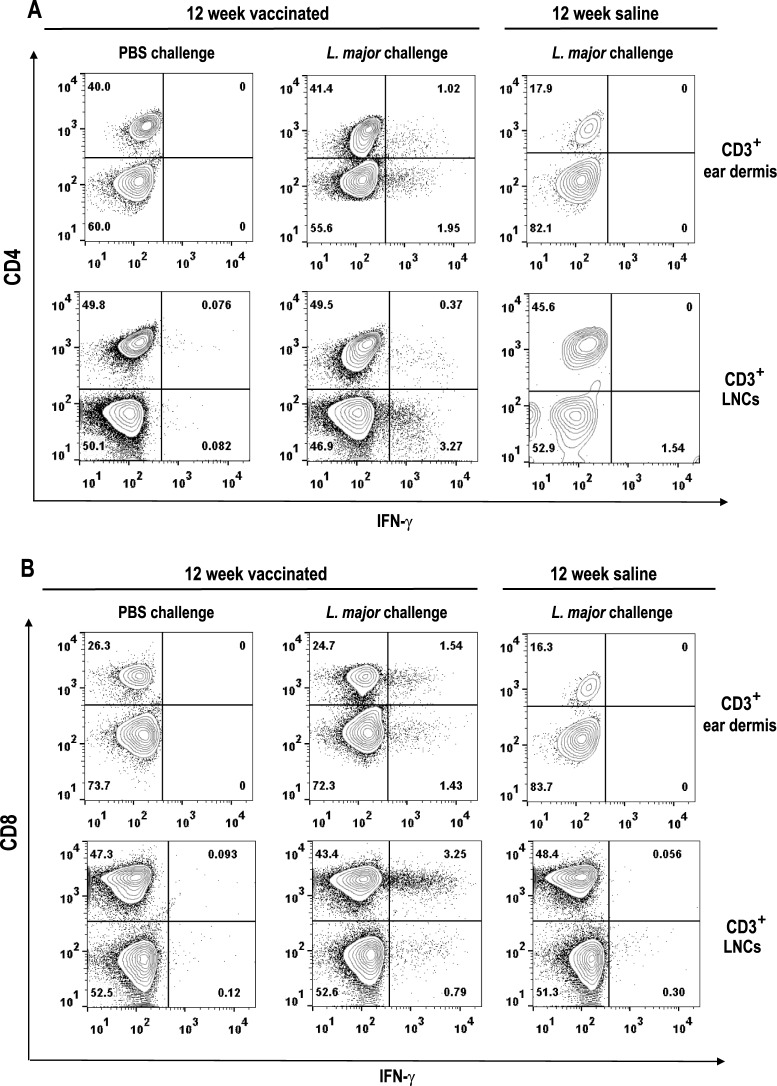
Analysis of the early response after L. major challenge in the site of infection.C57BL/6 mice were inoculated with PBS (12 week saline group; n = 6) or with 1 × 107
LiΔHSP70-II promastigotes (12 week vaccinated group; n = 10) in the right footpad (s.c.). After 12 week, vaccinated animals were inoculated with PBS (PBS challenge; n = 5) or infected with 1 × 105
L. major metacyclic promastigotes (L major challenge; n = 5) in the dermis of both ears. Mice inoculated in the right footpad (s.c.) with PBS (12 week saline group) were also challenged with L. major in the ear dermis. Three days after infection T cells from the ears and retromandibular lymph nodes were analyzed in pool by flow cytometry after anti-CD3/anti-CD28 ex vivo stimulation. Contour plots of IFN-γ intracellular staining for CD4+ (A) or CD8+ (B) cells (gated on CD3+) are shown. Numbers represent the percentage of each population.